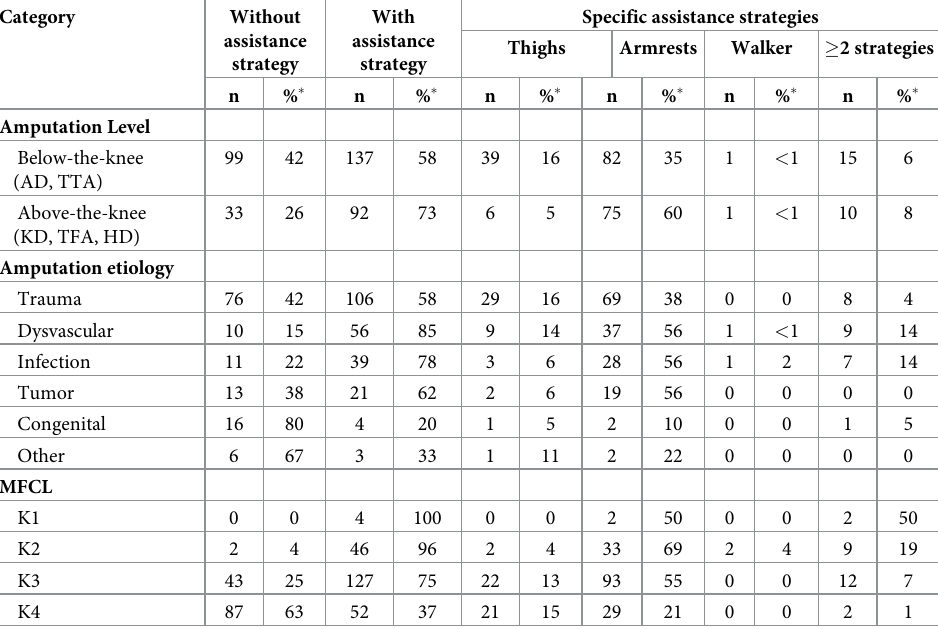
Table 2. Assistance strategies used by participants (n = 361) to complete the m5xSTS Test based on amputation level, cause of amputation, age, and Medicare Functional Classification Level (MFCL).